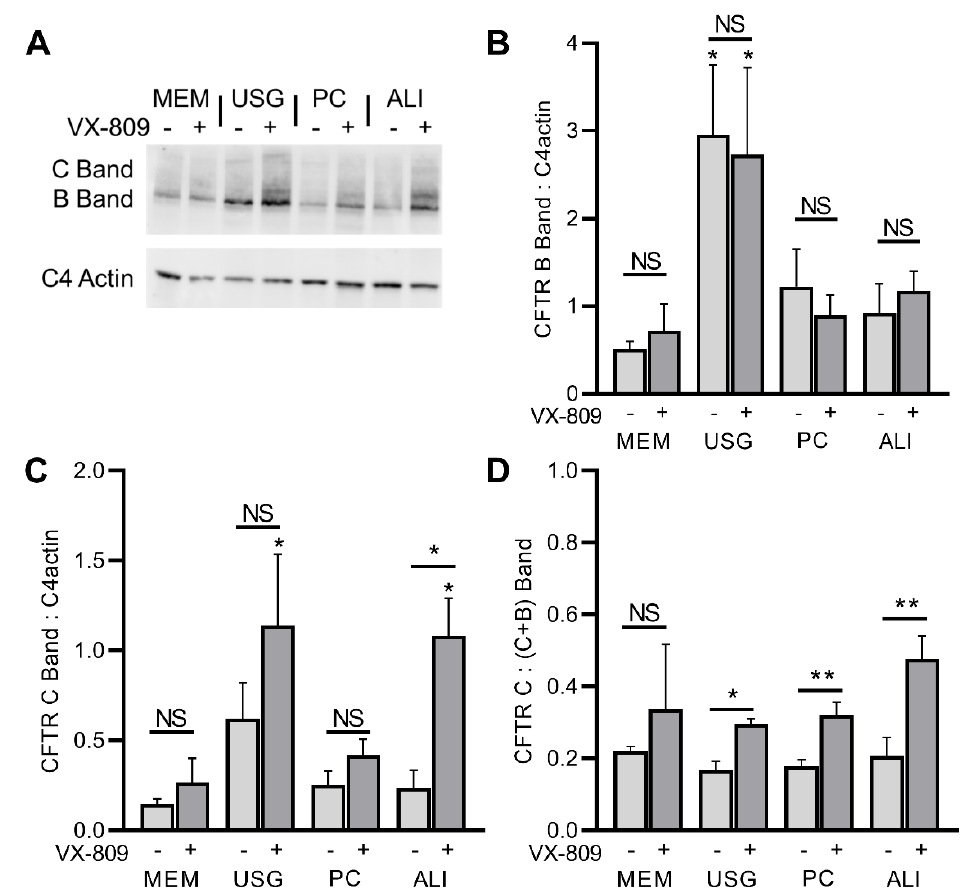
Figure 3. F508del CFTR protein expression is increased in USG media, with similar VX-809-induced rescue of C Band in all media. Immunoblot for CFTR was performed and quantified for untreated and VX-809-treated F508del CFTR-expressing CFBE41o- cells ( A ). Densitometry was calculated relative to C4 actin and presented for Band B (immature) ( B ) and Band C (glycosylated) ( C ). The fraction of glycosylated wtCFTR protein (Band C/[Band C + Band B]) is quantified in ( D ). Light grey bars—vehicle; dark grey bars—VX-809. For each within-media-vehicle- and VX-809-treated pair (e.g., MEM with/without VX-809), comparisons by 2-tailed T test are presented above the relevant paired bars. Comparisons across media within treatment categories (e.g., MEM, USG, PC, and ALI treated with vehicle) were conducted by one-way ANOVA with Dunnett’s multiple comparisons correction, noting significant differences against MEM via asterisk(s) above the individual data bar. * p < 0.05; ** p < 0.01; NS: Not Significant.